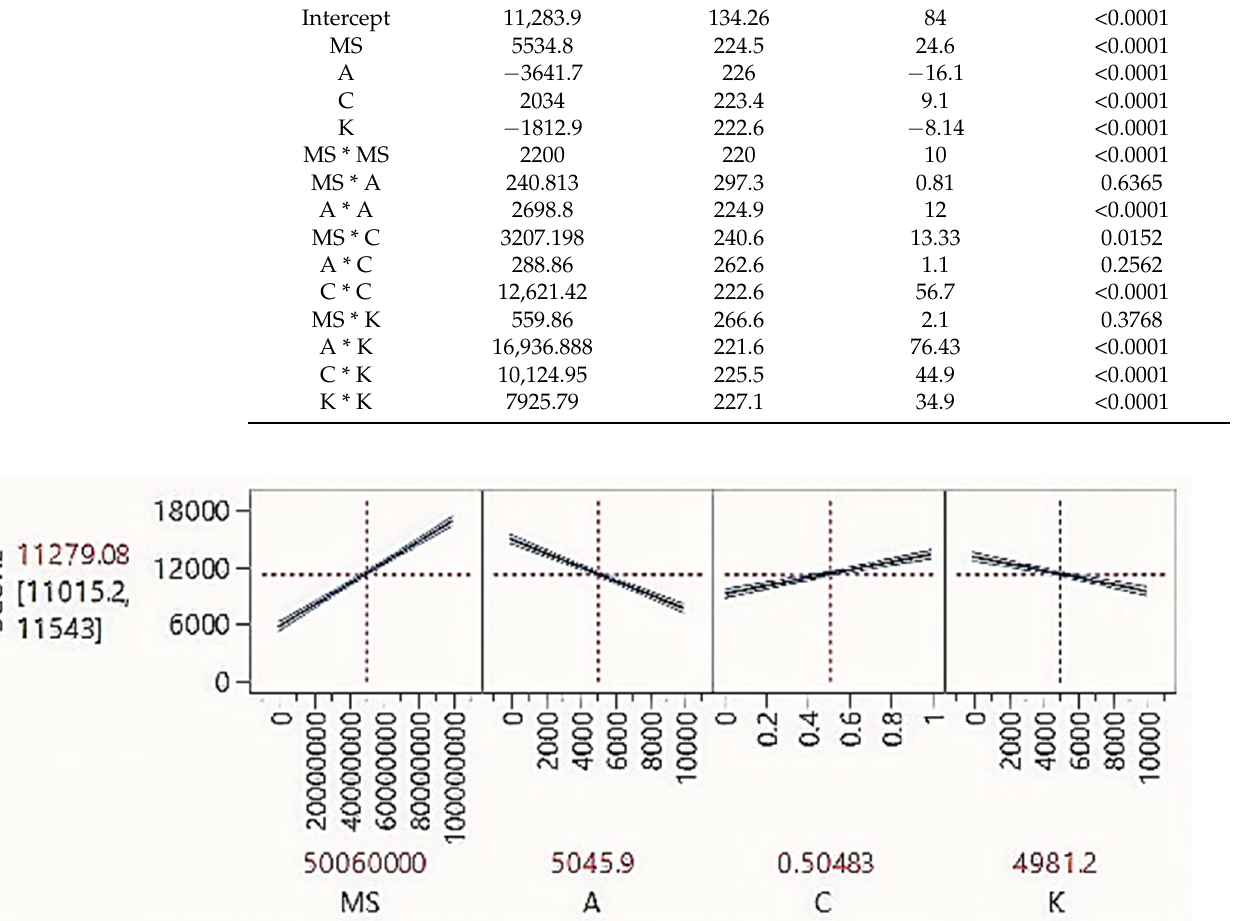
Table 1. Parameter estimates of linear model effects.